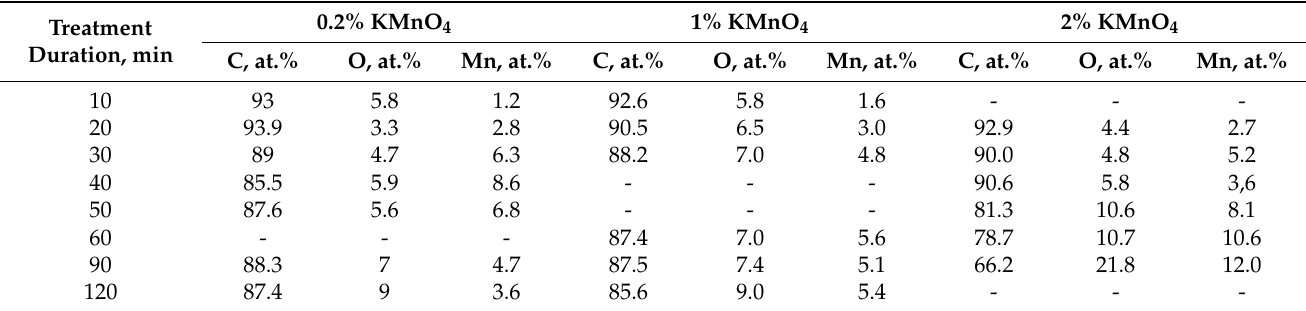
Table 1. Element concentrations in the active layer of MnO 2 /MWCNT/Al samples depending on the treatment duration and the concentration of the KMnO 4